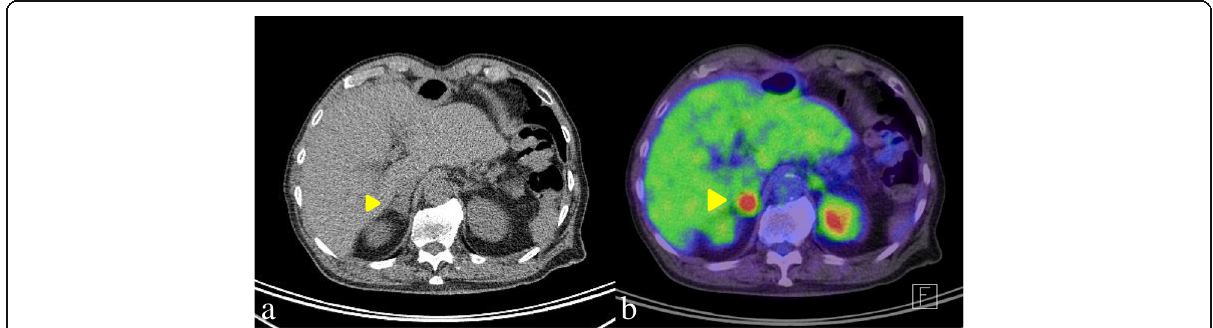
Fig. 2 Images from CT and FDG-PET/CT. a A mass with a 2-cm diameter in the right adrenal gland. b PET/CT shows high accumulation of FDG (standardized uptake value max, 7.67) in the right adrenal mass. Abbreviations: CT computed tomography, PET positron emission tomography, FDG